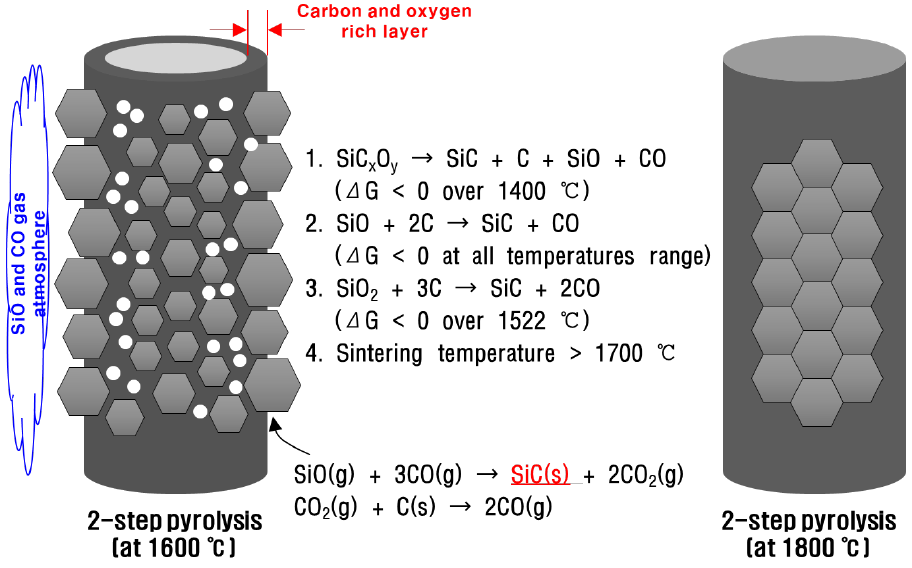
Figure 7. The schematic drawing of the crystallization behavior of polymer-derived SiC fibers.